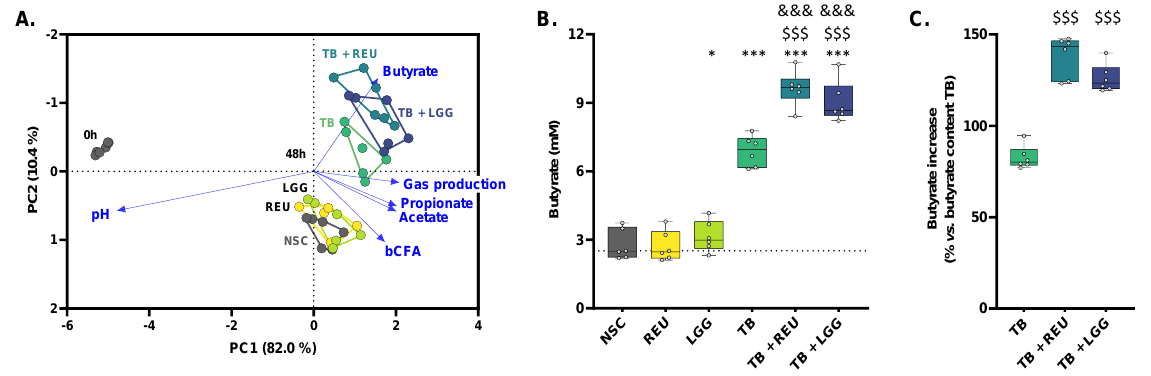
Figure 3. TB increased butyrate levels, which were further enhanced upon REU/LGG co-supplementation. ( A ) Principal component analysis (PCA) biplot summarizing the impact of two Lactobacillaceae species (LGG and REU), tributyrin oil (TB), and combinations thereof on markers of microbial activity, compared to an untreated NSC, at 0 h (INO) and after 48 h of colonic incubations for human adults (n = 6). ( B ) Butyrate levels (mM) and ( C ) proportional butyrate increase compared to the NSC, versus the theoretical butyrate content of TB (1 g TB/L = 4.96 mM butyrate). The line in the box plot is shown at the median value in the NSC. Statistical differences compared to the NSC are indicated with * (0.01 < p adjusted < 0.05), ** (0.001 < p adjusted < 0.01) or *** ( p adjusted < 0.001), while differences between TB + REU/TB + LGG and TB are indicated with $$$ ( p adjusted < 0.001). Differences between TB + REU/TB + LGG and the respective probiotic (REU/LGG) are indicated with &&& ( p adjusted < 0.001). bCFA = branched fatty acids; NSC = no substrate control; REU = Limosilactobacillus reuteri ; LGG = Lacticaseibacillus rhamnosus.